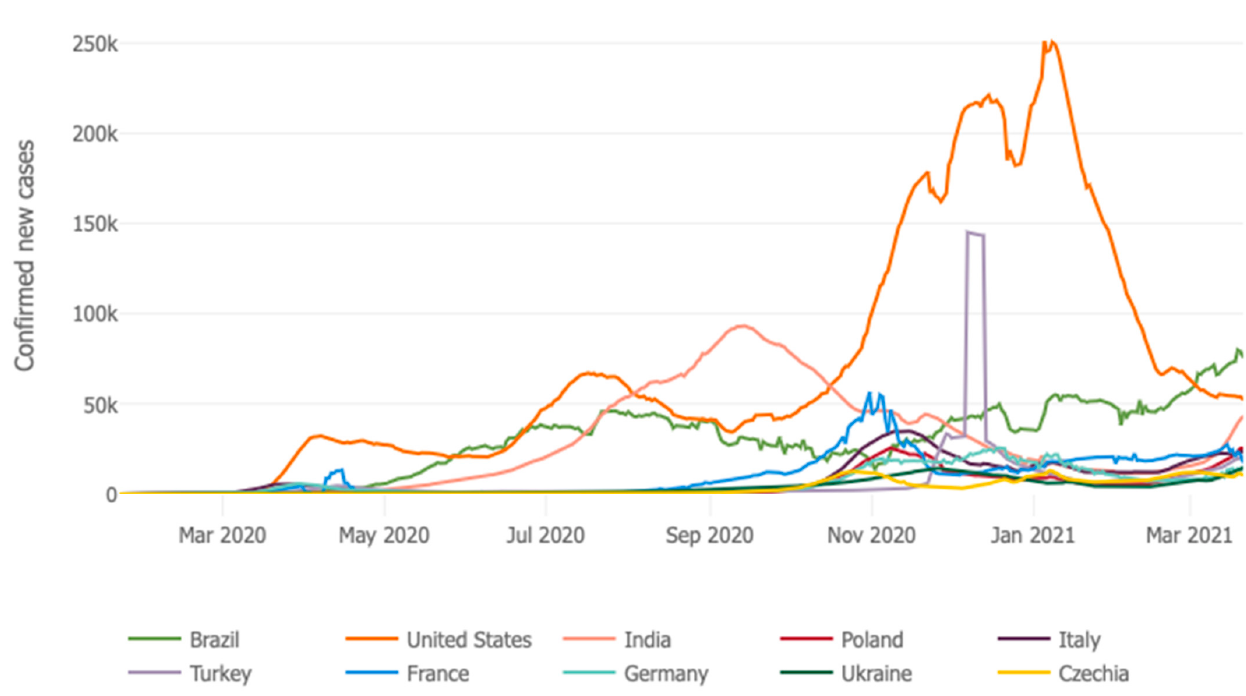
Figure 4. Confirmed cases of the coronavirus in selected nations over time. Source: Johns Hopkins University, Coronavirus Resource Center [48].